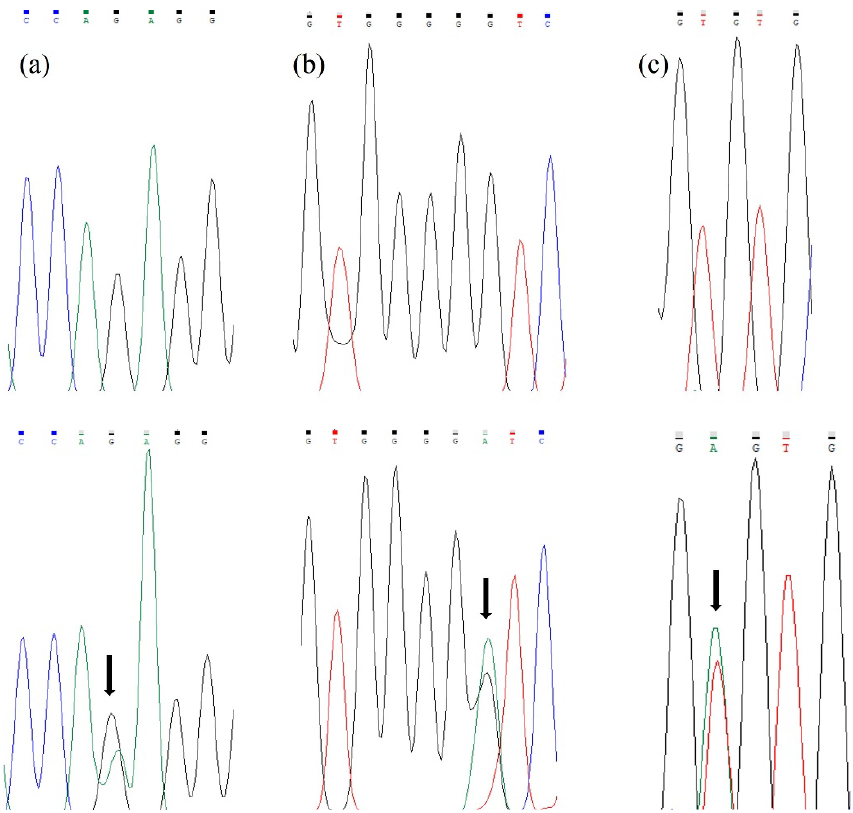
Figure 1. Electropherograms showing both the wild-type homozygous state of the HR gene and its heterozygous state. Illustrated in this figure are the unreported synonymous transition c.750G > A p.(Gln250Gln) ( a ), the non-synonymous transition c.1010G > A p.(Gly337Asp) (previously reported as polymorphism rs12675375) ( b ), and the previously unreported non-synonymous transition c.3215T > A p.(Val1072Glu) ( c ). Table 2. HR gene variant frequencies. Table 3. Bioinformatic analysis for non-synonymous